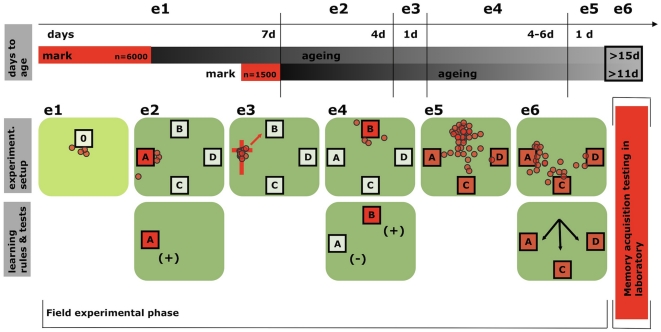
Experimental design used for inducing spatial memory extinction of a nest site and relating this extinction performance with olfactory learning decline.e1–e6 denote the separate events that constituted the spatial memory experiment. The upper row “days to age” depicts the overall timeline of the experiment. To control for foraging duration, foragers of random age were marked in two rounds. The initial day of olfactory learning performance scoring, these foragers constituted a heterogeneous age cohort with fully mature to old individuals that had been foraging for more than 15 respectively 11 days. The middle (“experiment. setup”) and lower rows (“learning rules and tests”) show the sequence of events that were used to induce spatial memories of the different nest sites. Bees returning from foraging flights were marked (event e1). Subsequently, they were moved to a distant test arena with four hive boxes (e2). Except for A, all other hive boxes (‘dummies’) were empty. After foraging, bees were given 4 days for learning to orient towards A. Thereafter, an artificial swarm was produced (e3, compare Fig. 2A) and was moved to location B (e4). Colonies were then given another 4–6 days to learn the spatial setting of the new home site B, while learning to extinguish the memory of the previous home site A, which remained closed (unrewarded ‘dummy’ location). Lastly, the entire worker population of the colony was dumped to the ground (e5). The hive box at B was removed, forcing foragers to orient towards the previous location A or alternative locations C, D (e6). At this time all locations A, C, D were similarly equipped with unrelated queens, young workers (<48 h old) and combs to resemble functioning hives. The next day, marked bees were collected, individual orientation preference was logged, and specimens were subjected to olfactory memory acquisition tests in the laboratory.